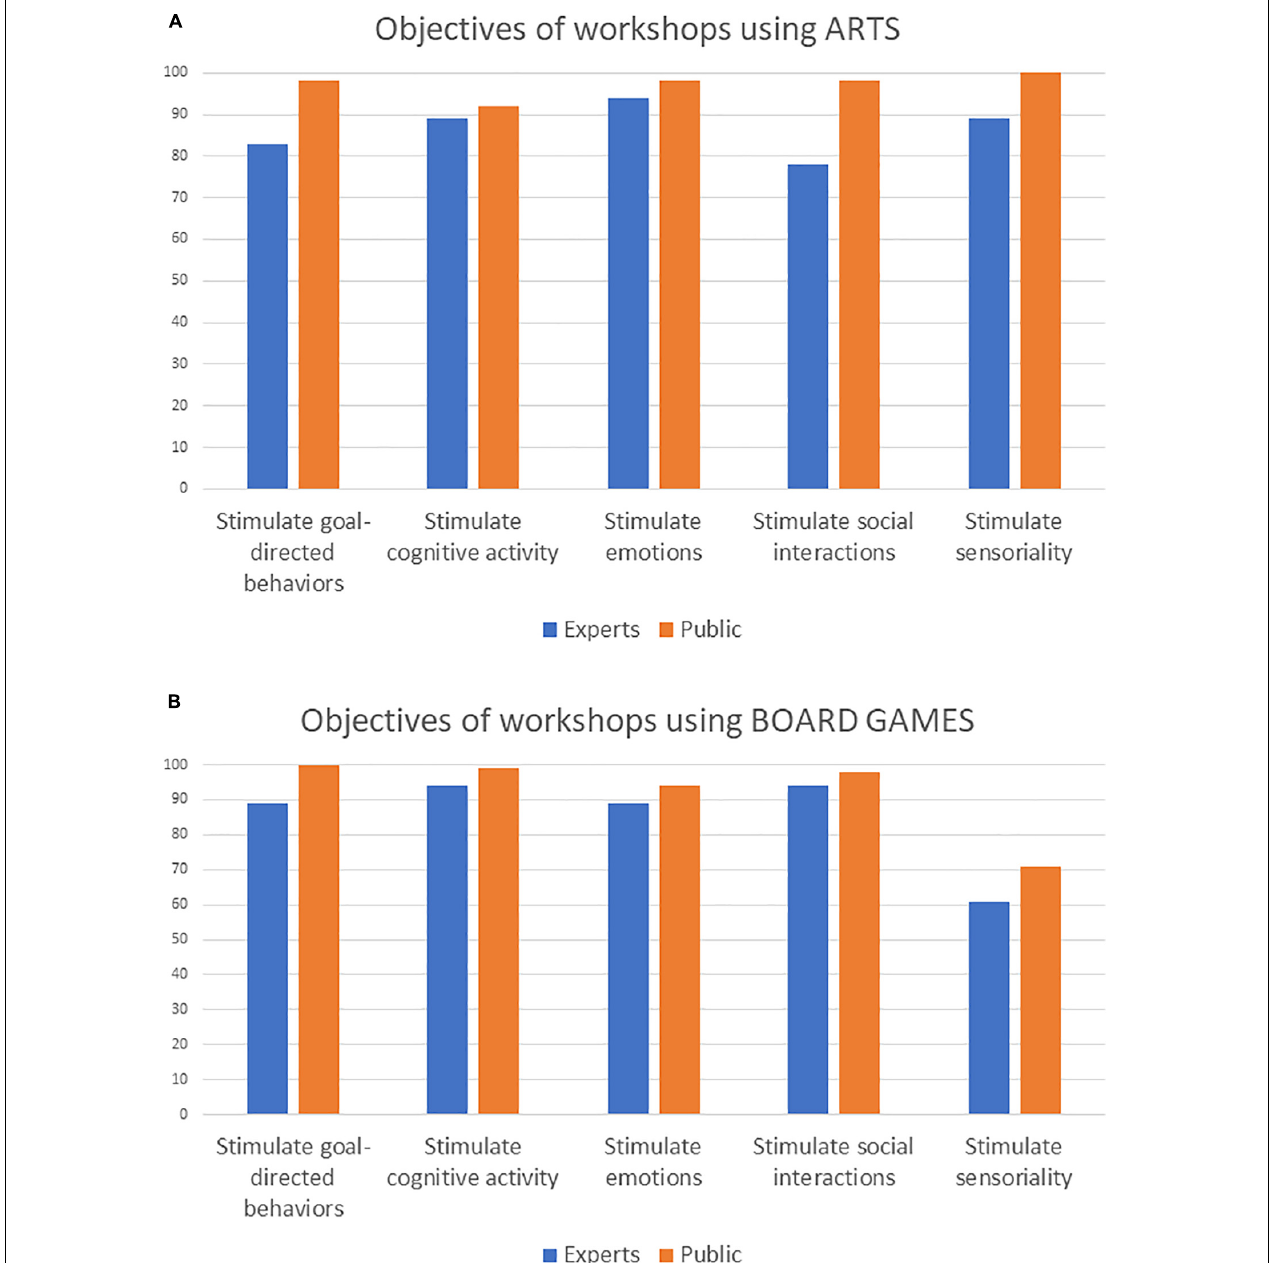
FIGURE 2 | Percentage of experts ( N = 18) and general public ( N = 101) agreeing on the objectives of workshops using (A) arts and (B) board-games.